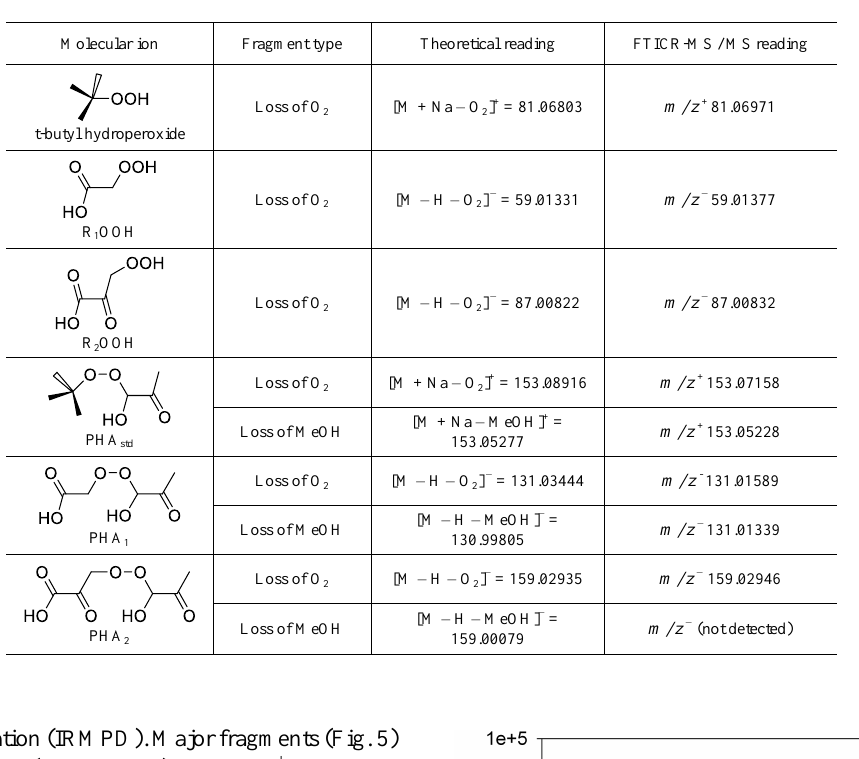
Table 2. FTICR-MS/MS and theoretical readings for fragments of peroxyhemiacetals and organic peroxides.